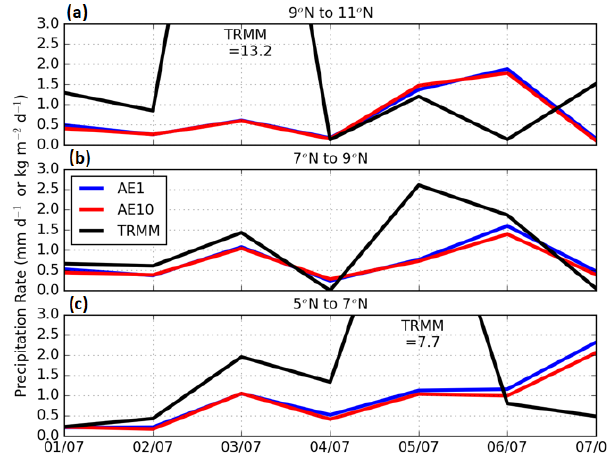
Figure 11. Daily precipitation rates measured by the TRMM instru- ment (black line) and modeled by the AE1 (blue line) and AE10 (red line) experiments for the period 1–7 July 2016, averaged over three areas extending from 1 to 4 ◦ E, and (a) from 9 to 11 ◦ N, (b) from 7 to 9 ◦ N, and (c) from 5 to 7 ◦ N.